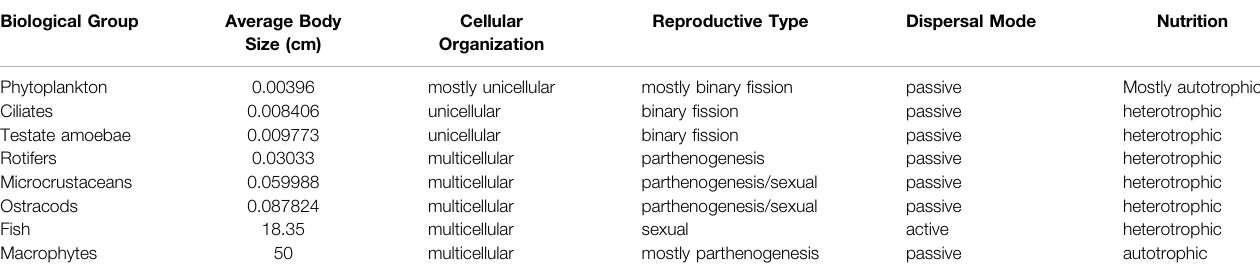
TABLE 1 | Comparisons of the major cross-biological group functional traits.